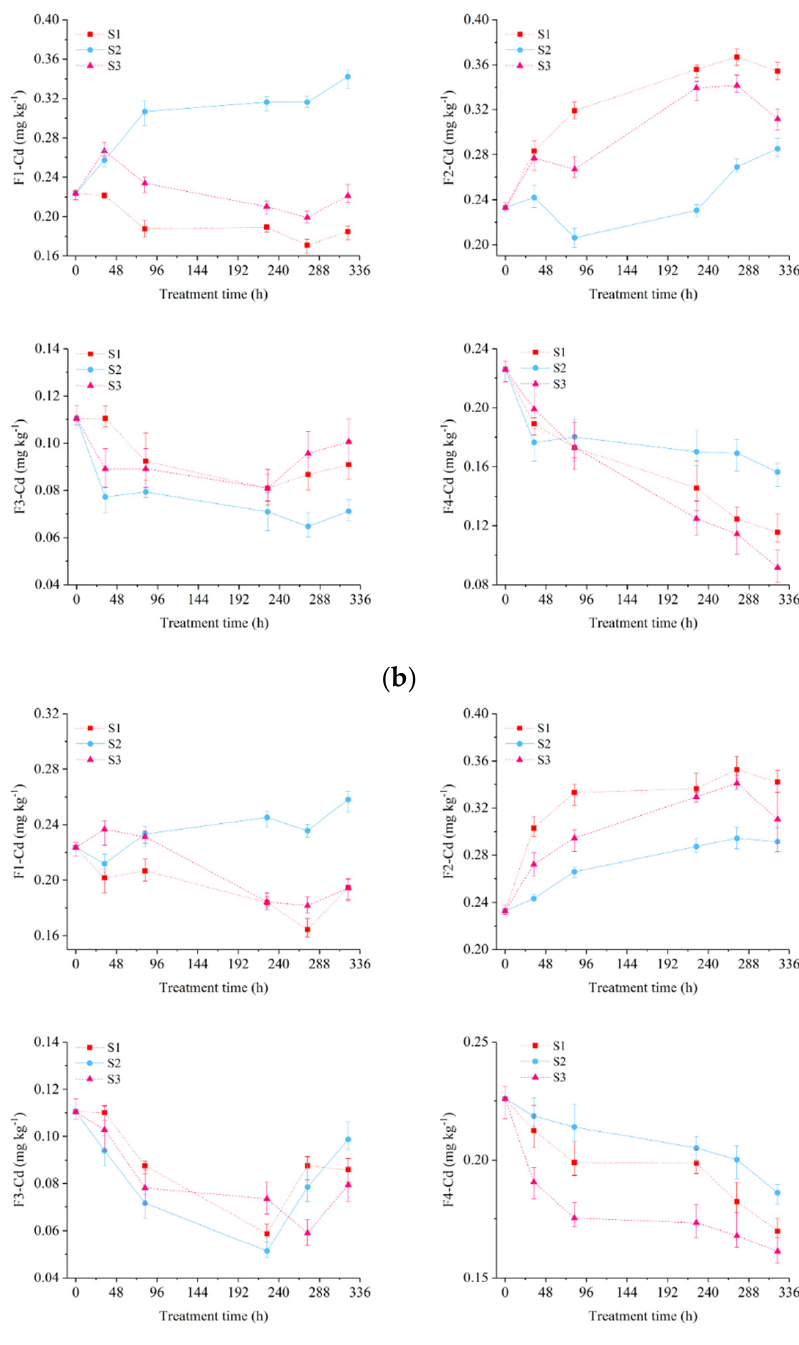
Figure 3. Variation of Cd fraction concentration at EKR 1.0 ( a ), EKR 0.8 ( b ), and EKR 0.5 ( c ), respec- tively. F1-Cd, F2-Cd, F3-Cd, and F4-Cd were the exchangeable fraction, reducible fraction, oxidizable fraction, and residual, respectively.